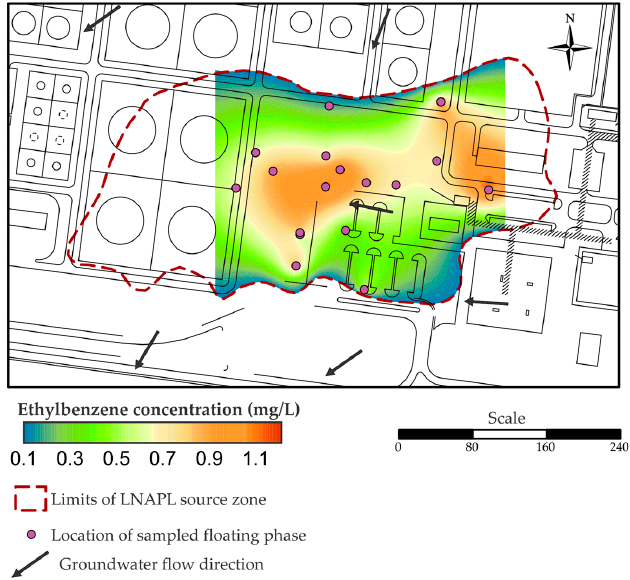
Figure 3. Ethylbezene concentrations in the LNAPL. The map was built using the analytical results presented by Teramoto [36].